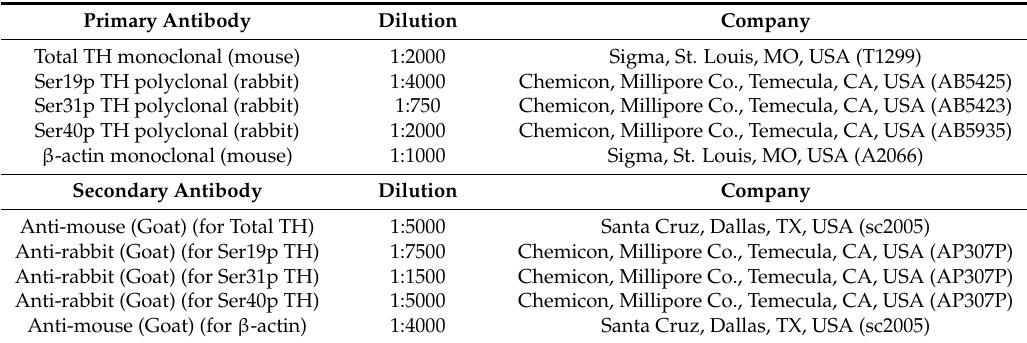
Table 4. Antibodies used for western blot assays. Primary and peroxidase-conjugated secondary antibodies. Catalogue numbers are shown between brackets.